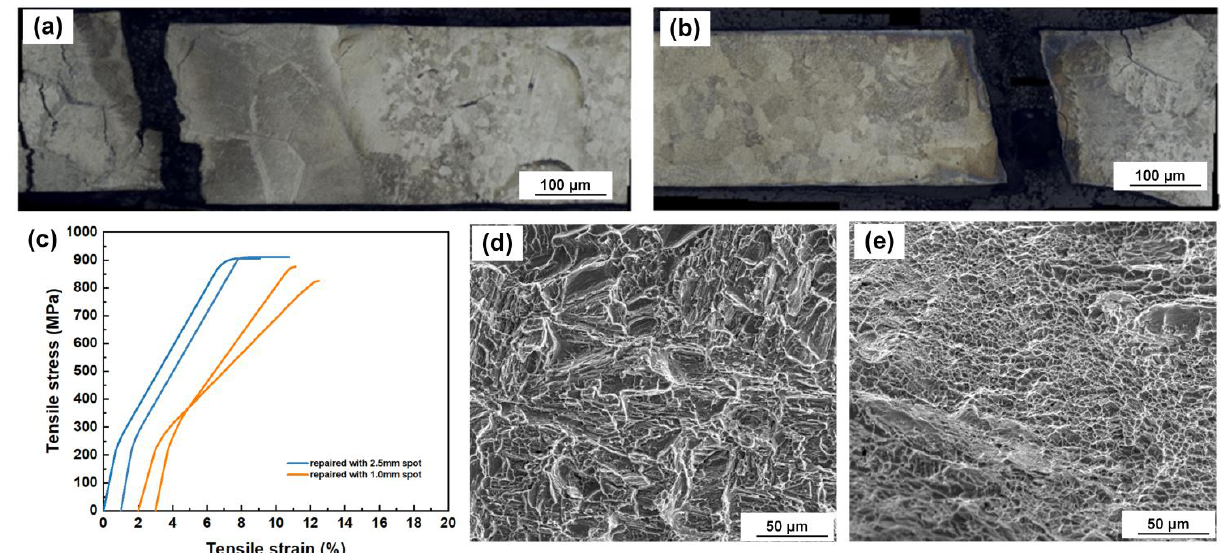
Figure 15. Fractured behaviors for two samples: ( a ) Fractured location for the samples obtained under three repaired layers, ( b ) Fractured location for the samples under five repaired layers, ( c ) Tensile curves for two samples, ( d ) Quasi-cleavage fractured surface for sample obtained under three repaired layers, ( e ) Cleavage fractured surface for sample obtained under five repaired layers.